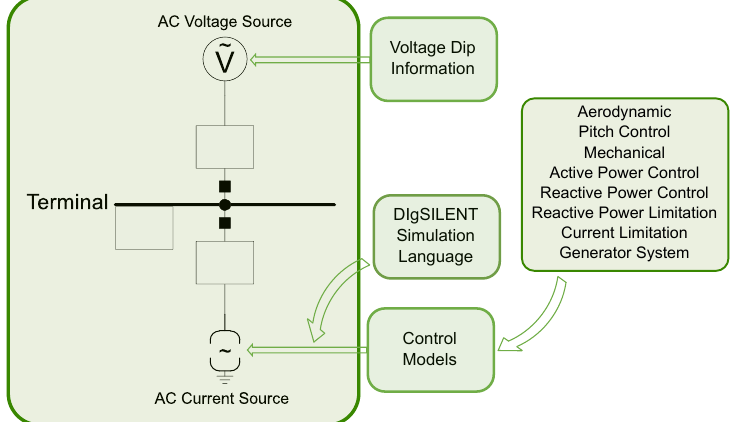
Figure 8. Test network modeled in DIgSILENT-PowerFactory: interconnection of the dynamic control models using DSL.